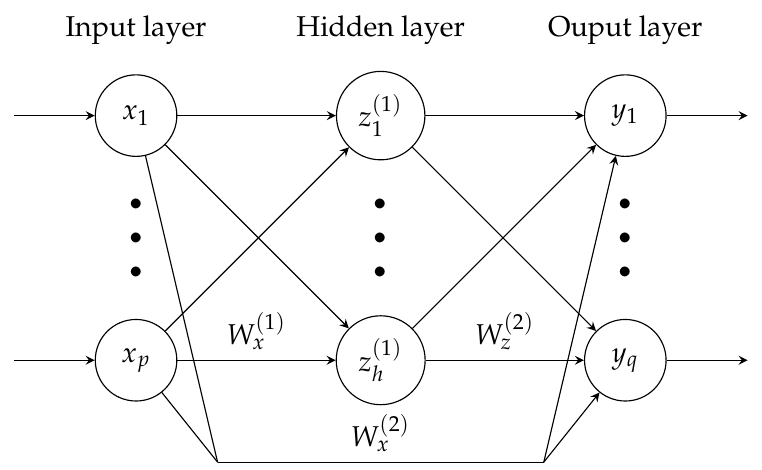
Figure 3. Graphical representation of a fully connected cascade-forward neural network with one hidden layer. The network features p input nodes x 1... p , h hidden neurons z The respective weight matrices are denoted by W